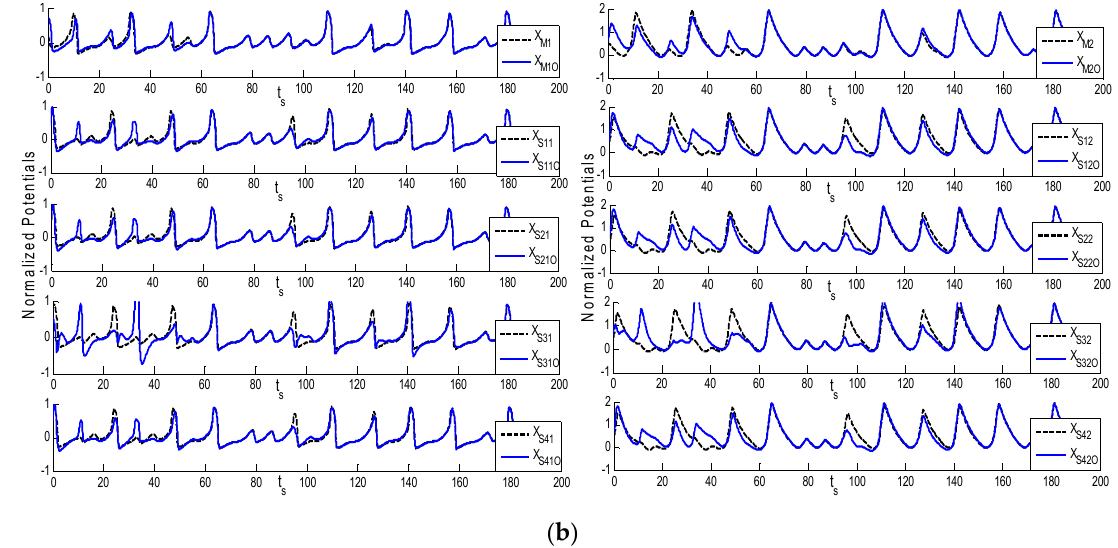
Figure 3. ( a ) Normalized potential of the master and four slave systems; ( b ) the respective observers of Theorems 1 and 2.